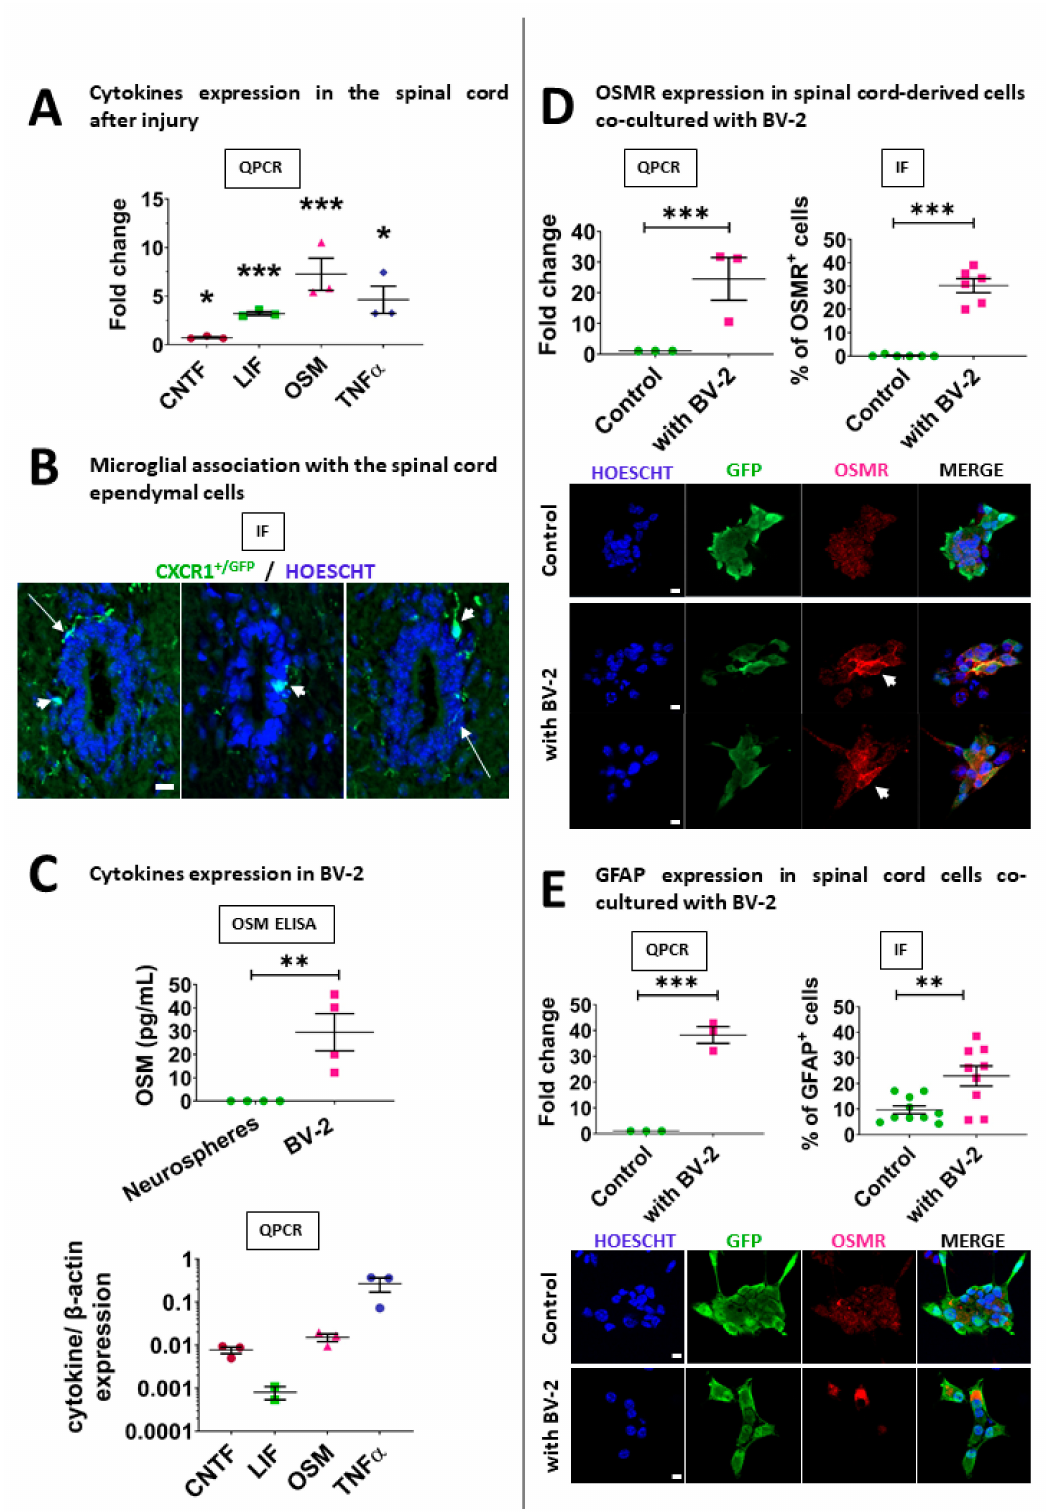
Figure 6. Microglia upregulate OSMR expression in spinal cord neurosphere cells. ( A ): QPCR for indicated cytokines in RNA extracted in sham-operated and injured spinal cord (3 days after SCI). n = 3 independent experiments. Numbers indicate the fold change compared to sham-operated spinal cords. Statistical tests were performed with Bootstratio (Cl è ries et al., 2012) compared to control spinal cords. ( B ): Immunofluorescences for GFP performed in CX3CR1 +/GFP mice to reveal microglia (green) associated with ependymal cells. White arrowheads and arrows show microglia somas and processes